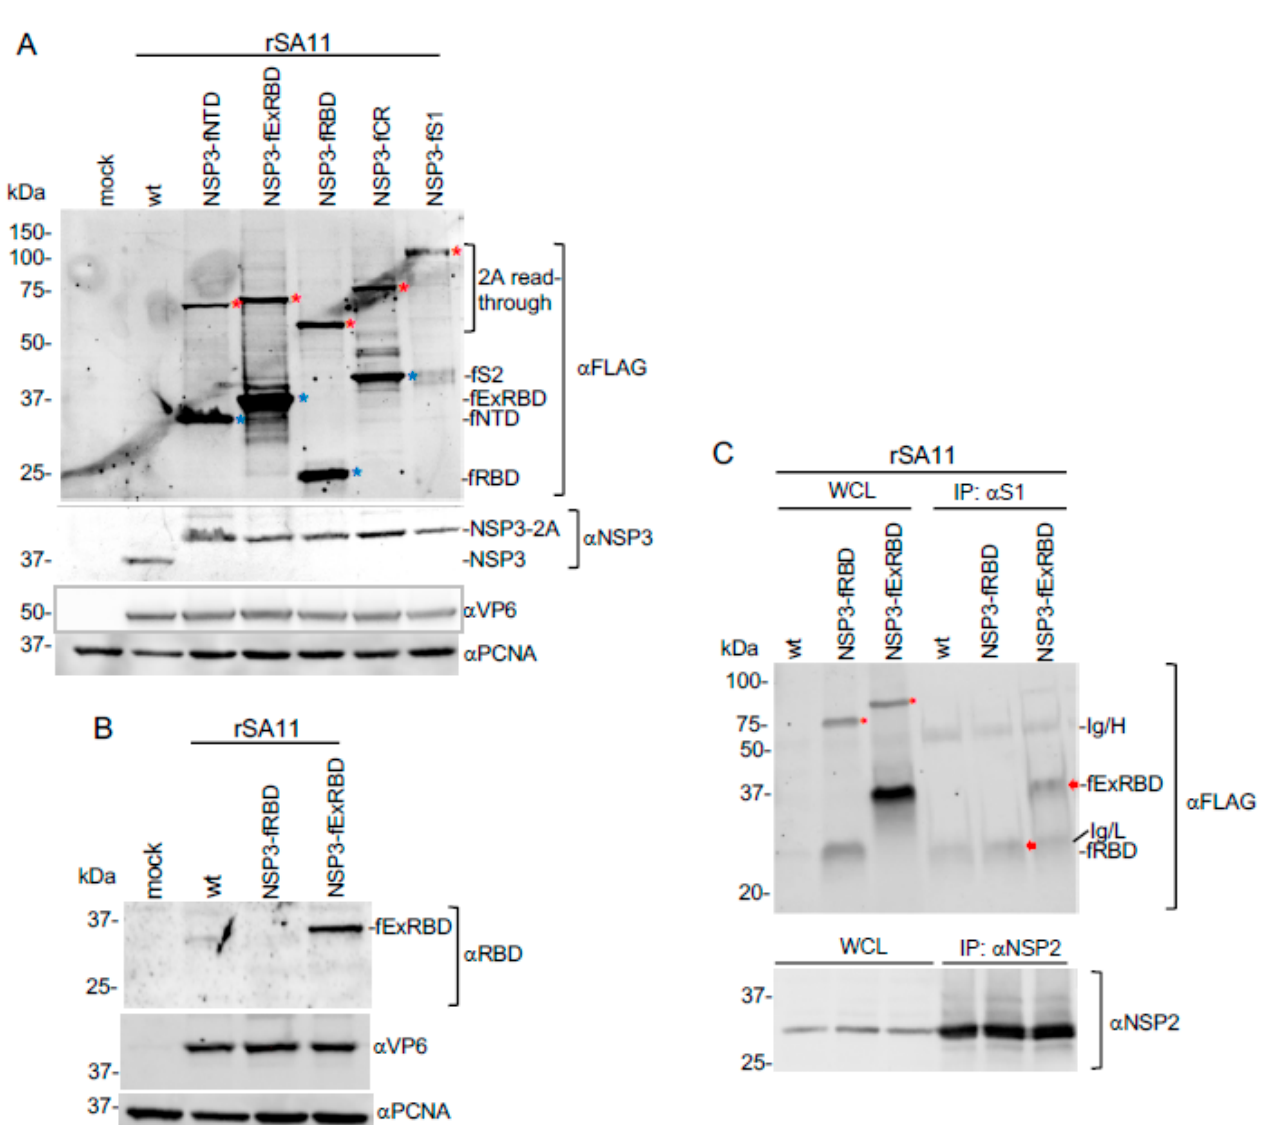
Figure 4. Expression of SARS-CoV-2 S products by rSA11 viruses. ( A , B ) Whole cell lysates (WCL) were prepared from cells infected with rSA11 viruses and examined by immunoblot assay using ( A ) FLAG antibody to detect S products (NTD, ExRBD, RBD, CR, S1, and 2A read-through products) and antibodies specific for rotavirus NSP3 and VP6 and proliferating cell nuclear antigen (PCNA). Red asterisks (*) identify 2A read-through products and blue asterisks (*) identify 2A cleavage products. Cleaved fS1 product failed to be detected in five separate immunoblot assays analyzing two independently generated samples of MA104 cells infected with rSA11/NSP3-fS1 virus. ( B ) Lysates prepared from MA104 cells infected with rSA11wt, rSA11/NSP3-fRBD and rSA11/NSP3-fExRBD were examined by immunoblot assay using antibodies specific for RBD (ProSci 9087), rotavirus VP6, and PCNA. ( C ) Lysates prepared from MA104 cells infected with rSA11/wt, rSA11/NSP3-fRBD and rSA11/NSP3-fExRBD viruses were examined by immunoprecipitation assay using a SARS-CoV-2 S1 specific monoclonal antibody (GeneTex CR3022). Lysates were also analyzed with a NSP2-specific polyclonal antibody. Antigen-antibody complexes were recovered using IgA/G beads, resolved by gel electrophoresis, blotted onto nitrocellulose membranes, and probed with FLAG (fRBD and fExRBD) and NSP2 antibody. Molecular weight markers are indicated (kDa). Red arrows indicate fRBD and fExRBD. fRBD comigrates near the Ig light chain (Ig/L). Ig heavy chain, Ig/H).